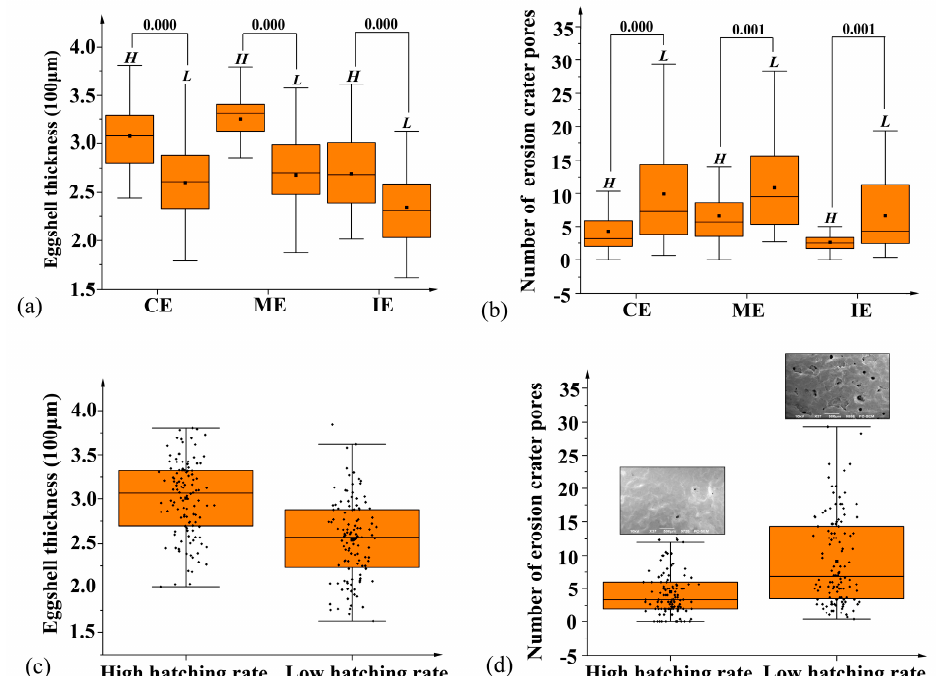
Figure 2. Box diagrams of the association between the hatching rate and eggshell thickness ( a ) and the number of erosion-crater pores ( b ) in the CE, ME, and IE regions, as well as the association of the hatching rate with the average number of pores ( d ) and average eggshell thickness ( c ). The results show progressive significance; the significance threshold was 0.05 and, thus, values lower than 0.05 indicated